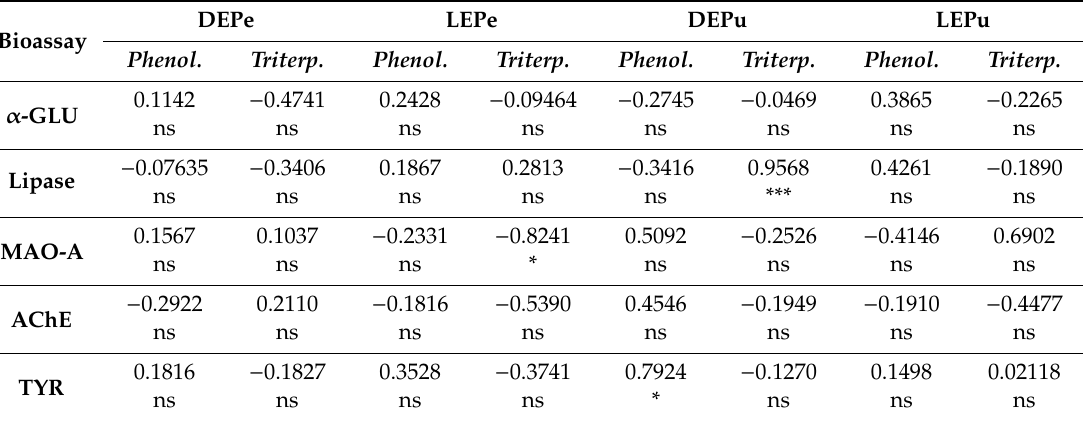
Table 4. Pearson r values and statistical significance for correlation analyses between polyphenol or triterpene contents of the di ff erent samples (DEPe, LEPe, DEPu, LEPu) and